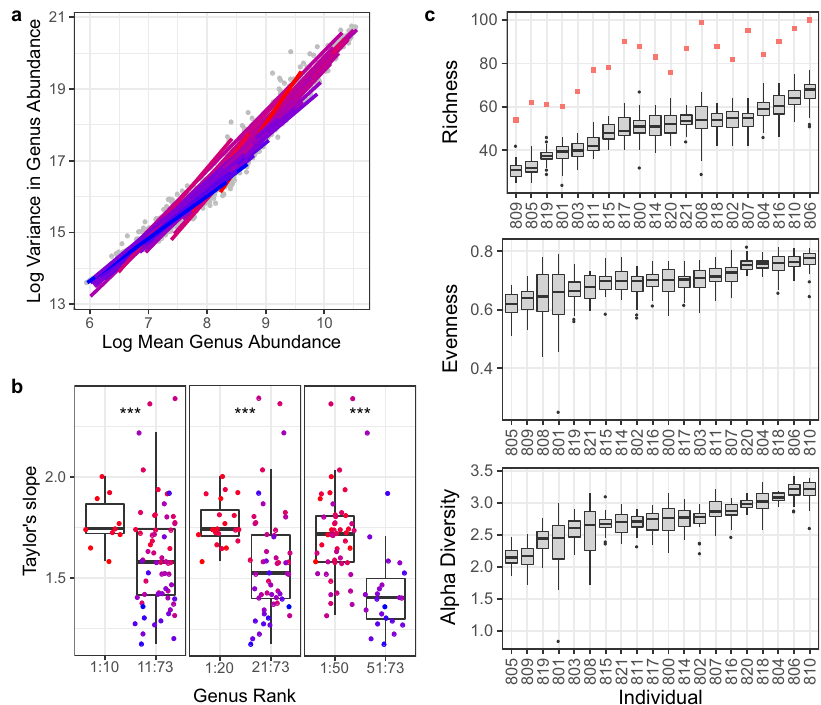
Fig. 2 High-ranked genera are more stable with increasing mean abundance than low-ranked genera. Mean-variance relationships can be characterized by a linear relationship known as Taylor ’ s Law (TL). According to TL log(variance) g = b × log(mean) g , where b is a species-speci fi c constant and g indicates the group of measurements. For a given unit change in the log(mean) of population abundance, the TL ’ s slope equals the change in log(variance), which measures heterogeneity or scatter in the distribution of population abundance. A greater slope in the temporal TL means a greater degree of change in the temporal variance of genus population abundance with respect to its temporal mean. Genera for which the TL slope is 2 have about the same coef fi cient of variation in all subjects. Genera for which the TL slope is less than 2 show more temporal variation in subjects in which they are more abundant. The reverse for genera for which the TL slope is greater than 2. Here, we show Taylor slopes of high ranked genera (over all individuals) are generally higher, indicating more variation with increasing mean abundance, compared to low ranked genera. a Mean-variance relationships for all genera satisfying the abundance and prevalence criteria (genera with abundance >0.5%, present in >5 individuals in >3 samples). Regression lines are colored according to Taylor ’ s slope from less steep (blue) to steep (red). b TL slope of high versus low-ranked genera, for the top 10, 20, and 50 genera ( t -test between TL slopes of top 10, 20, and 50 versus lower-ranked genera, two-sided, P = 0.00318, P = 0.0000285, P = 0.000188, respectively, N = 73). c Intra-individual variation in alpha diversity measurements, (top) observed richness with an indication of the total number of genera detected over all samples (squares), (middle) Pielou ’ s evenness index ‘ J ’ , and (below) Shannon alpha diversity index for each individual (ID-number 800 – 821) ( N = 20, n = 694). The body of the box plots represents the fi rst and third quartiles of the distribution, and the median line. Whiskers extend from the quartiles to the last data point within 1.5×IQR, with outliers beyond. Signi fi cance levels: ***: 0.001, **: 0.01, *: